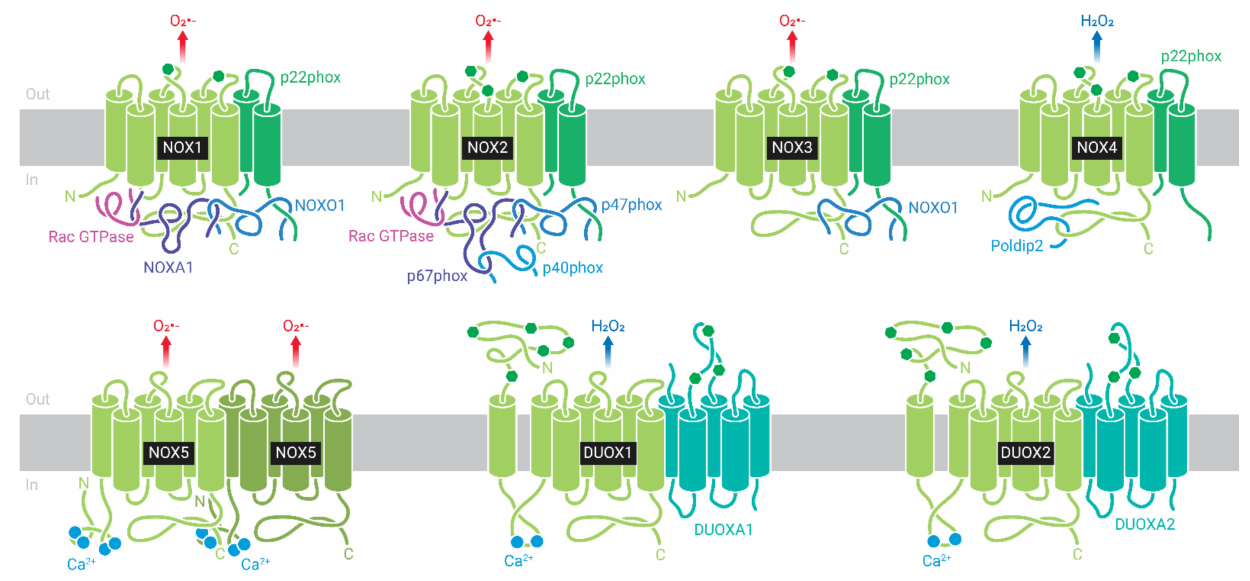
Figure 3. NADPH oxidase (NOX) family: NOX1, NOX2, NOX3, NOX4, NOX5, DUOX1, and DUOX2. NOX1-4 are stabilized by p22 phox subunit. NOX1 is activated by NOXO1/NOXA1 and Rac subunits, and NOX2 by p47 phox /p67 phox /p40 phox and Rac. NOX3 has constitutive activity, but binding to NOXO1/NOXA1 increases reactive oxygen species (ROS) production. NOX4 is constitutively activated. NOX4, NOX5, and DUOX1-2 do not interact with regulatory subunits. NOX5 and DUOX1-2 do not depend on p22 phox for stabilization and are activated by Ca 2+ . NOX1, NOX2, NOX3, and NOX5